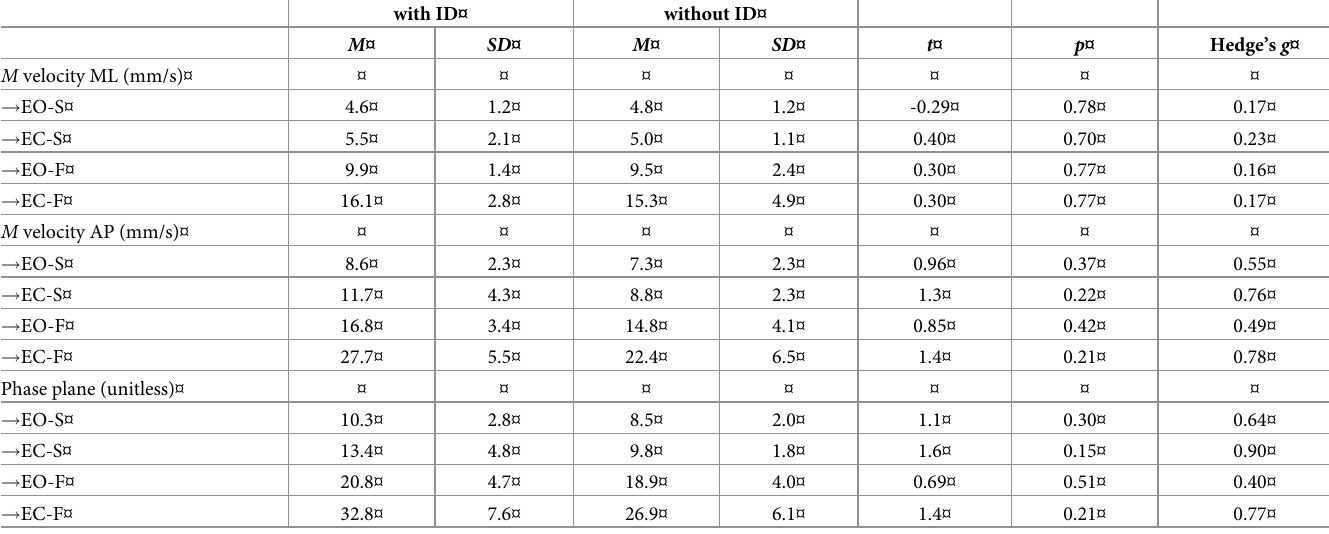
Table 3. Means and standard deviations of center of pressure parameters of participants with and without intellectual disability (ID), as well as values for t -statistic, significance ( p ), and effect size (Hedge’s g